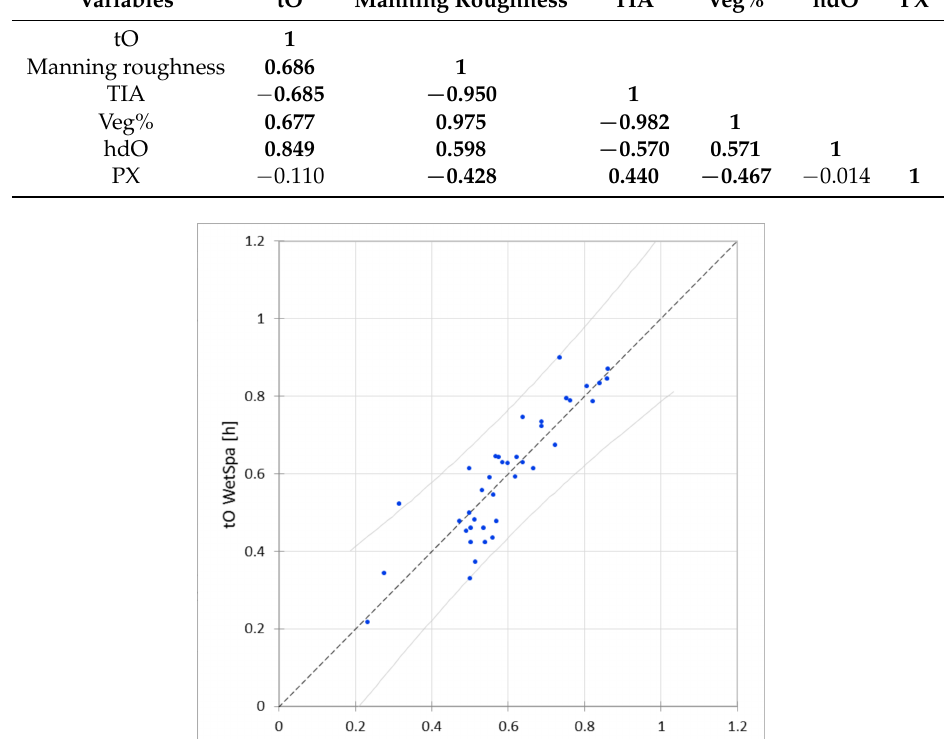
Table 4. Correlation matrix (Pearson) for the routing process. Values in bold are different from 0 with a significance level alpha = 0.05.